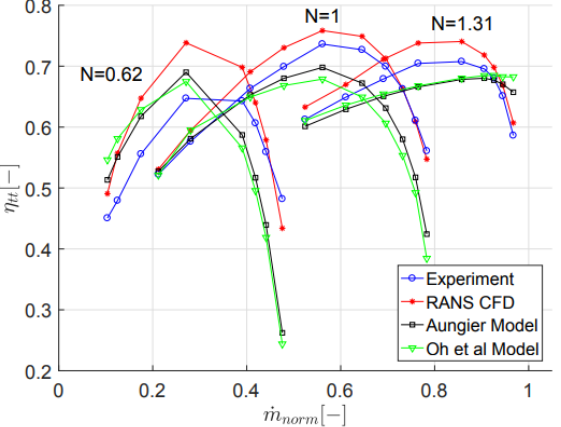
Figure 1. Isentropic Efficiency of the Experiment compared with Reynolds-averaged Navier–Stokes (RANS) computational fluid dynamics (CFD), and the two prediction models.